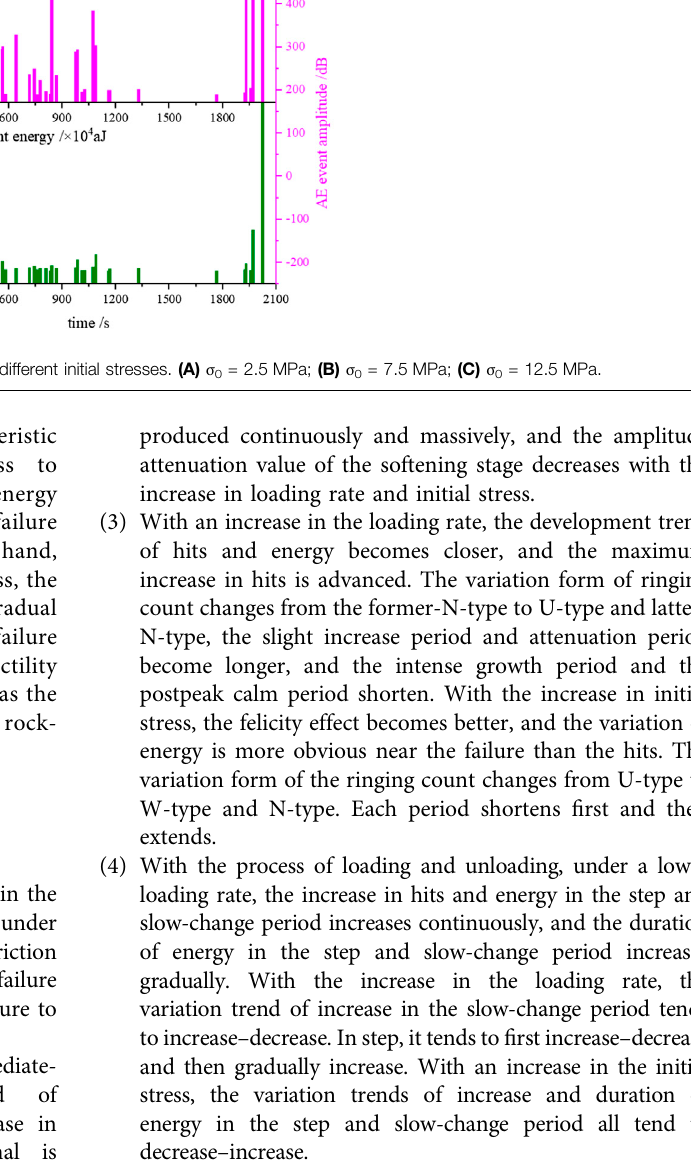
Frontiers in Physics |